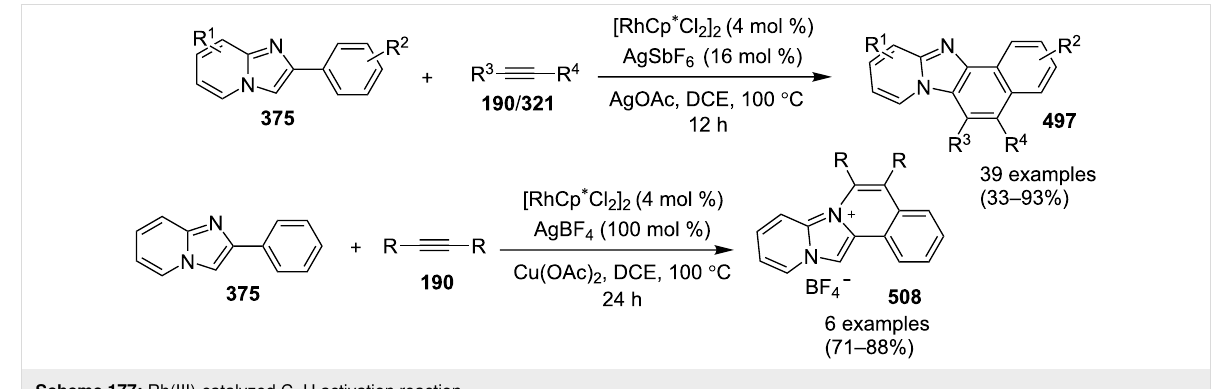
Scheme 176: Mechanism for Rh(III)-catalyzed oxidative coupling reaction.